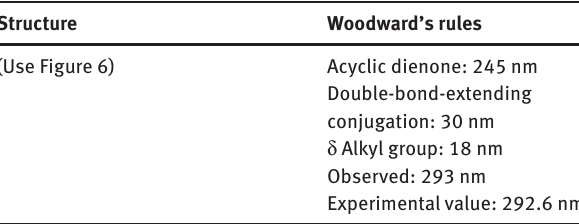
Table 4: Ultraviolet-visible (UV-Vis) wavelength prediction by Wood- ward’s